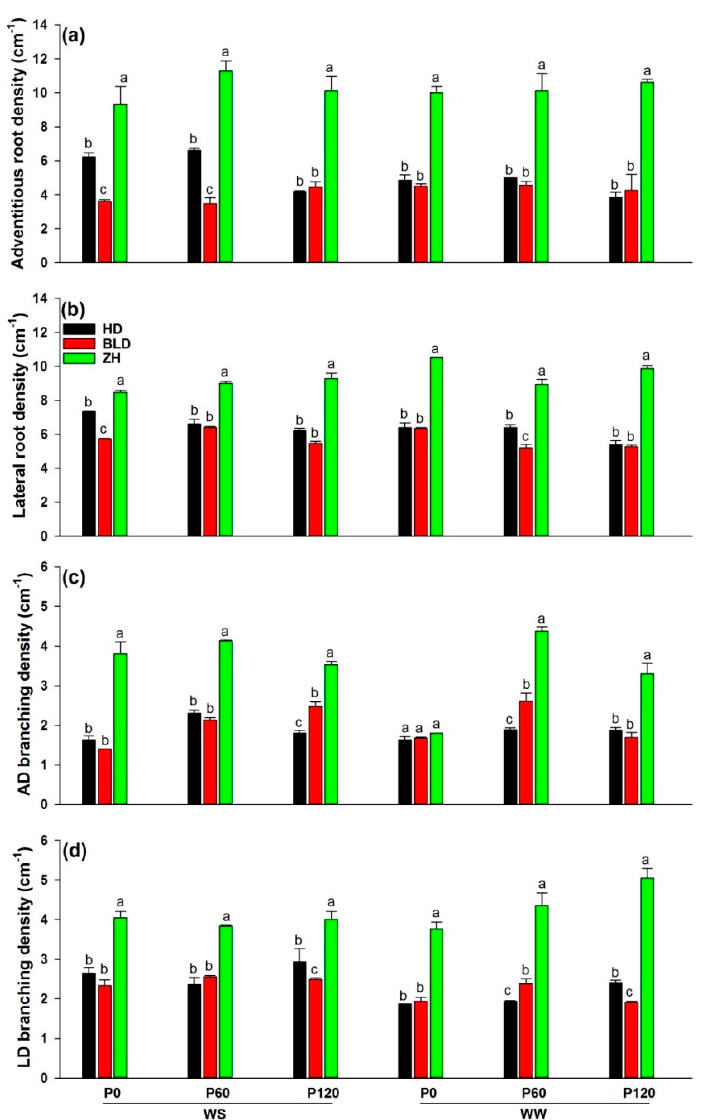
Figure 3. ( a ) Adventitious root (AD) density (cm − 1 ), ( b ) lateral root (LD) density (cm − 1 ), ( c ) AD branching density (cm − 1 ), and ( d ) LD branching density (cm − 1 ) at maturity of three soybean geno- types (Huandsedadou (HD), Bailudou (BLD), and Zhonghuang 30 (ZH)) exposed to three P concen- trations (0 (P0), 60 (P60) and 120 (P120) mg P kg − 1 dry soil) under water-stressed (WS) and well- watered (WW) conditions. Means ( n = 3) with different letters in any one set of three genotypes differ significantly at p = 0.05.